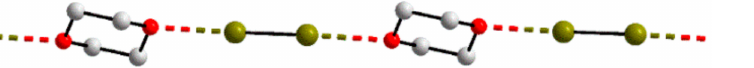
Figure 1. A view of a portion of the one-dimensional chain formed in the 1:1 multi-component crystal comprising Br 2 and dioxane. The molecule lies on a mirror plane as do the oxygen atoms of the dioxane molecule. Further, each component is disposed over a centre of inversion. The colour code in this and subsequent diagrams: bromide, dark green; oxygen, red; carbon, grey. Non-acidic hydrogen atoms are omitted for reasons of clarity. The halogen bond is represented by the dashed, multi-coloured bond coded in accordance with the participating atoms, in this case dark green and